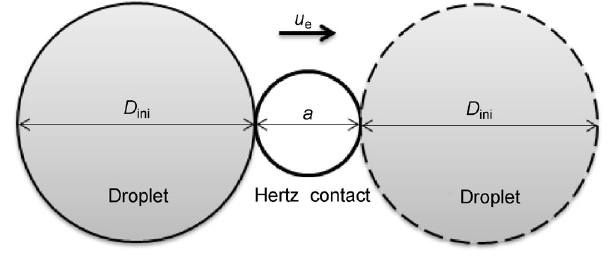
Fig. 10 Definition of nominal lubrication time.